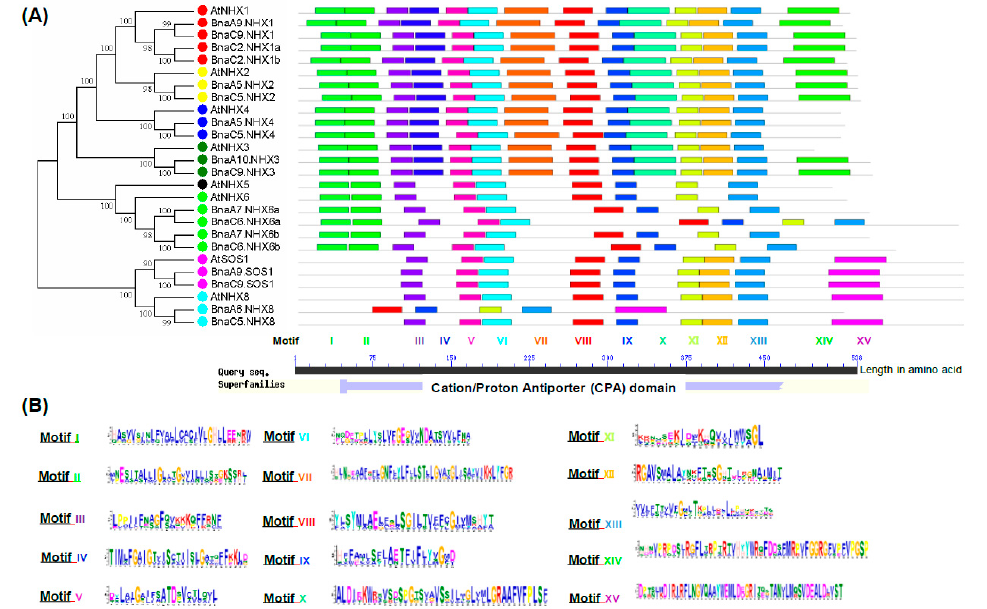
Figure 4. Identification and characterization of the conserved motifs in the Na + /H + antiporters (NHXs) in Arabidopsis thaliana and Brassica napus . Molecular identification ( A ) and sequence characterization ( B ) of the conserved motifs in the NHXs. In Figure 4 A , the boxes with di ff erent colors indicate di ff erent conserved motifs (motif I–XV), and grey lines represent the NHX regions without detected motifs. In Figure 4 B , the larger the fonts, the more conserved the